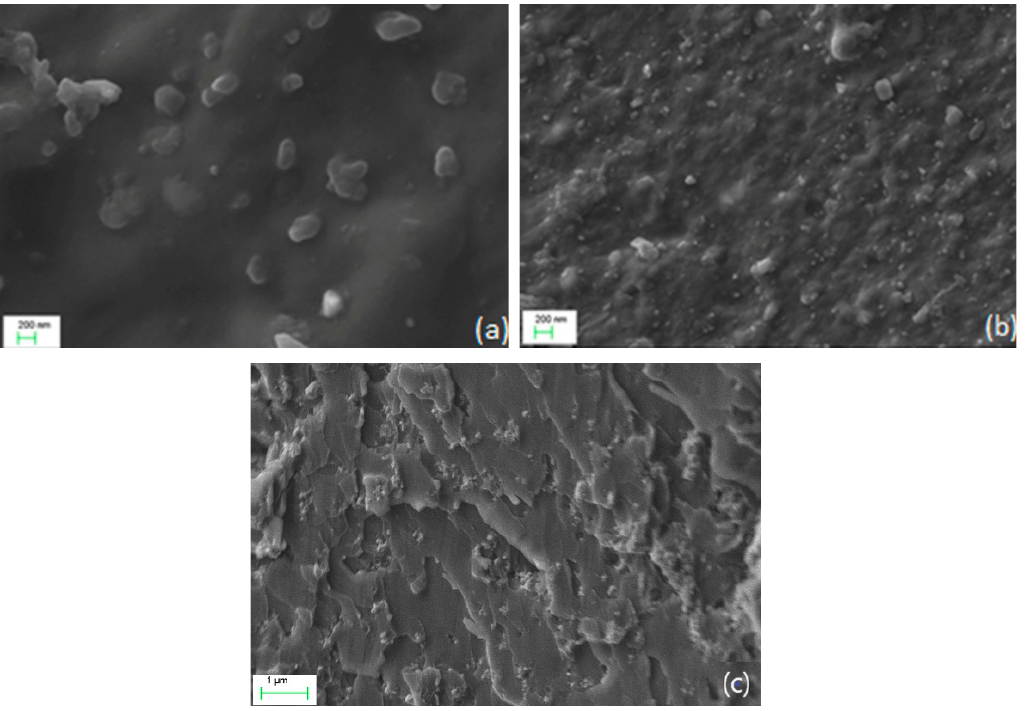
Figure 2. Representative SEM images of the: ( a ) 3 phr TiC/3 phr BN/epoxy, ( b ) 5 phr TiC/5 phr